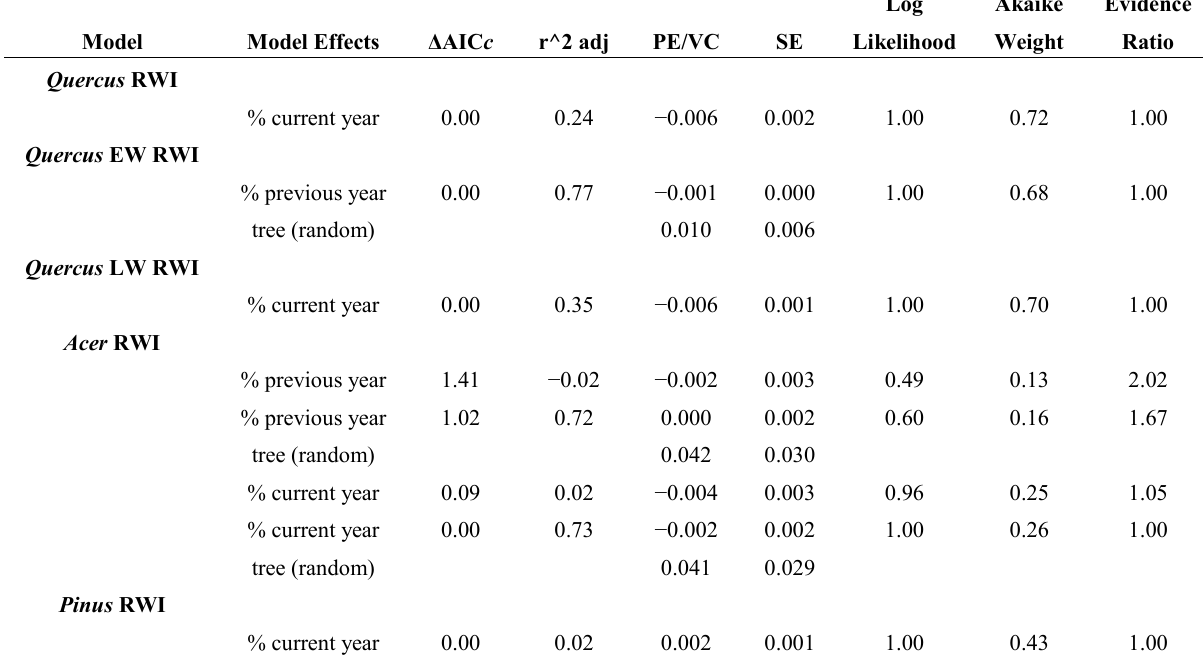
Log Akaike Evidence